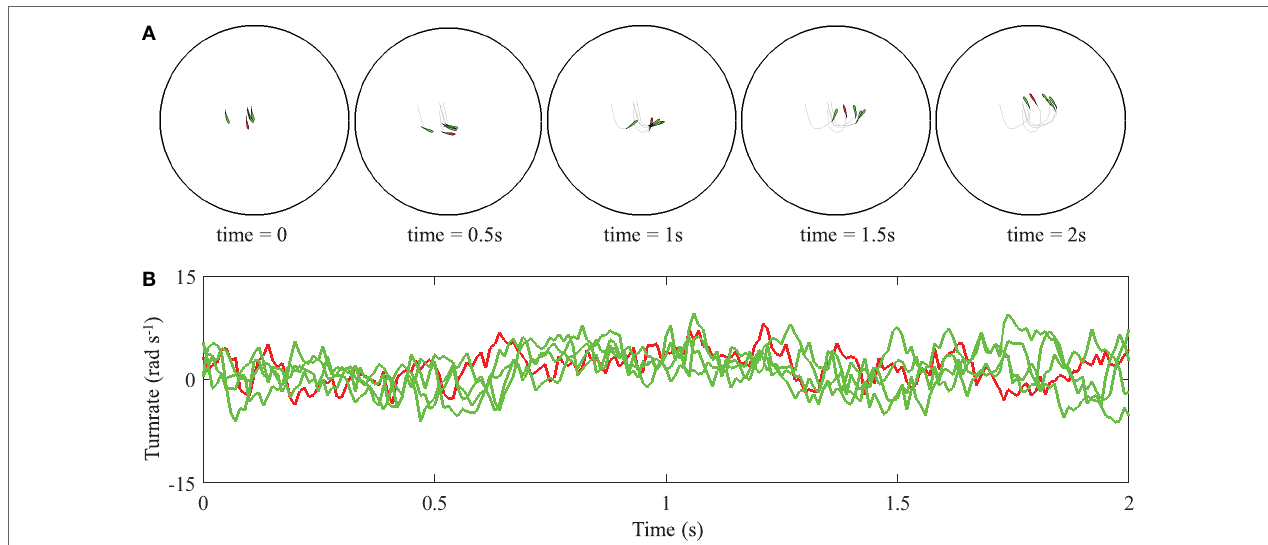
FIGURE 6 | Two seconds of trajectory traces (A) and turn rate evolution (B) of a group of simulated fish with a leader in red and four followers in green. In the graph, time equal to zero does not correspond to the beginning of the simulation, when fish are uniformly distributed in the circular domain.